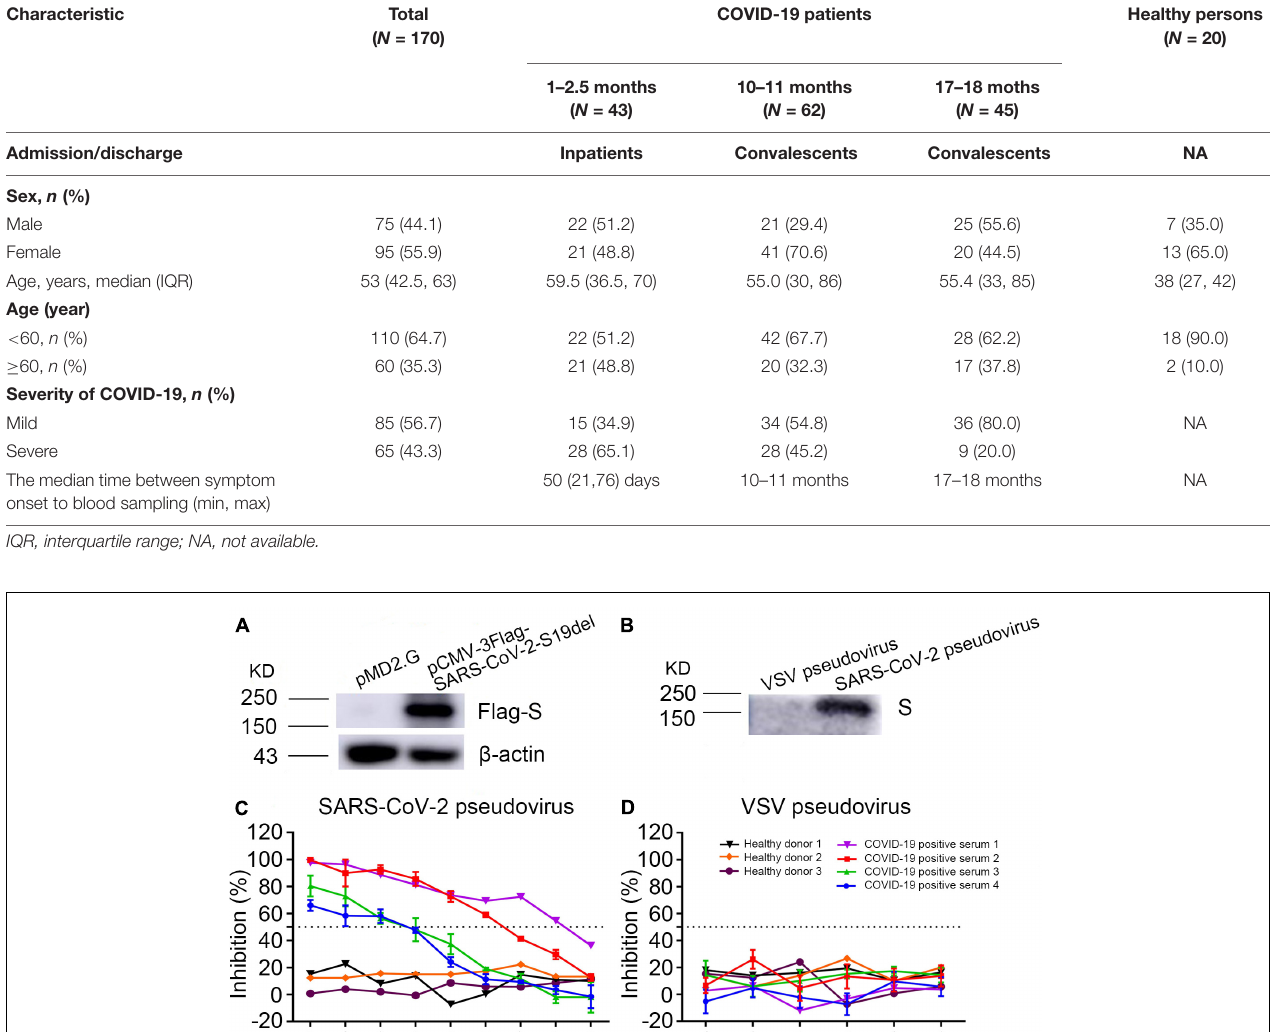
TABLE 1 | General information about cases enrolled in the neutralizing antibody test.